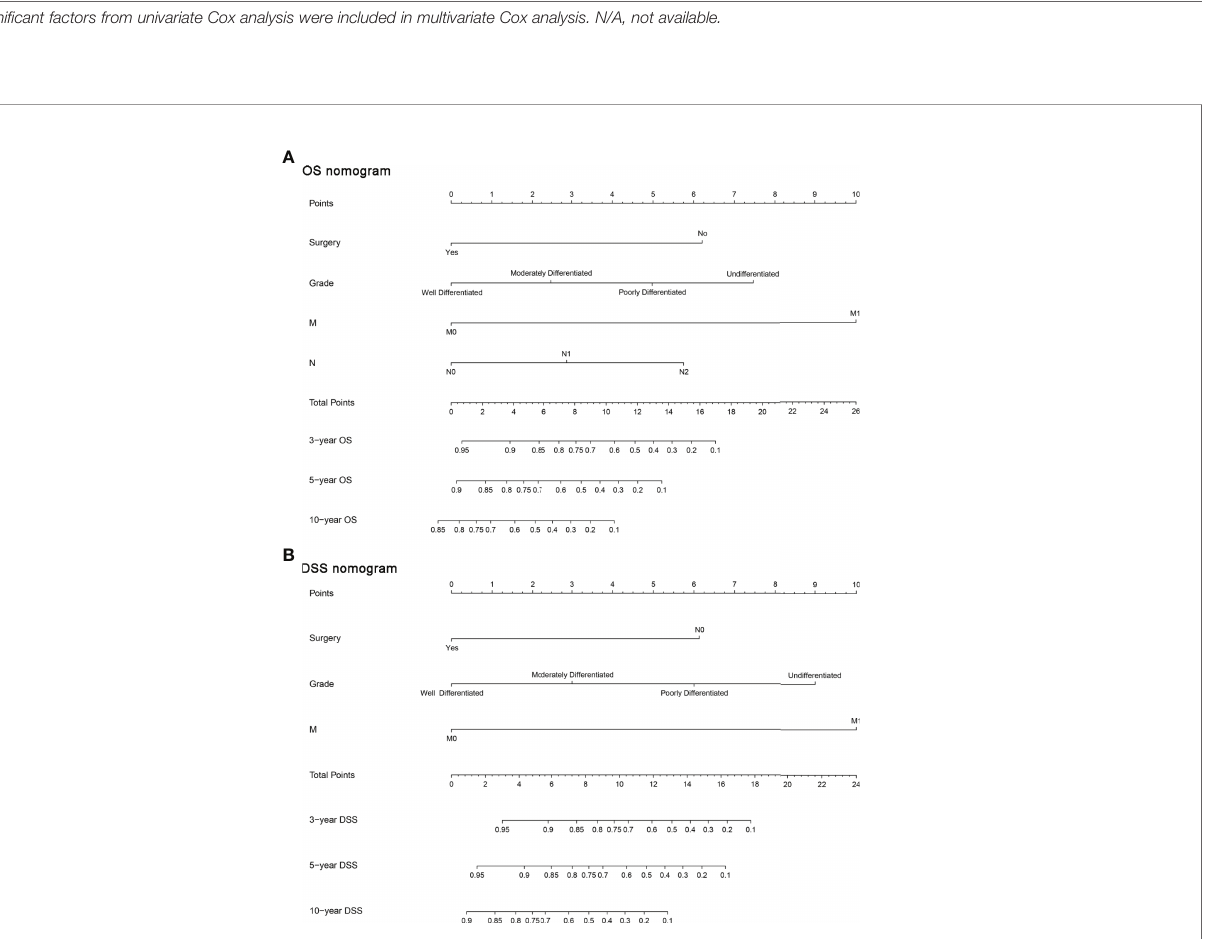
FIGURE 4 | The constructed prognostic nomogram for OS (A) and DSS (B) prediction. Each variable was assigned a score on the point scale. By summing the total score and locating it on the total point scale, a straight line was drawn down to determine the estimated probability of OS and DSS.